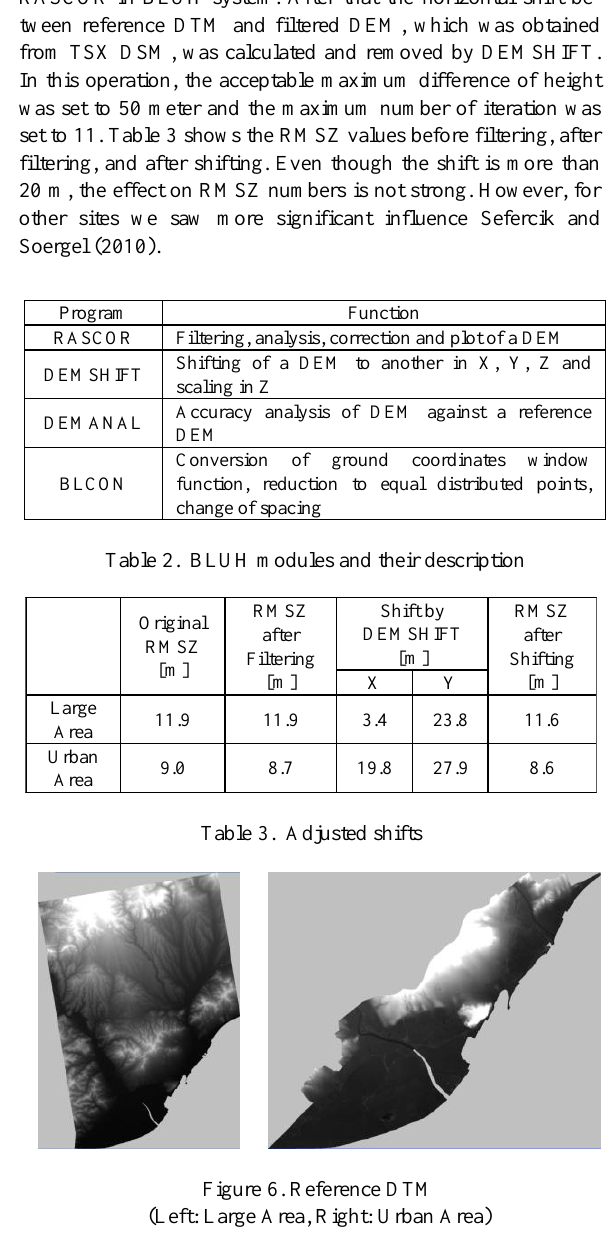
(Left: Large Area, Right: Urban Area)